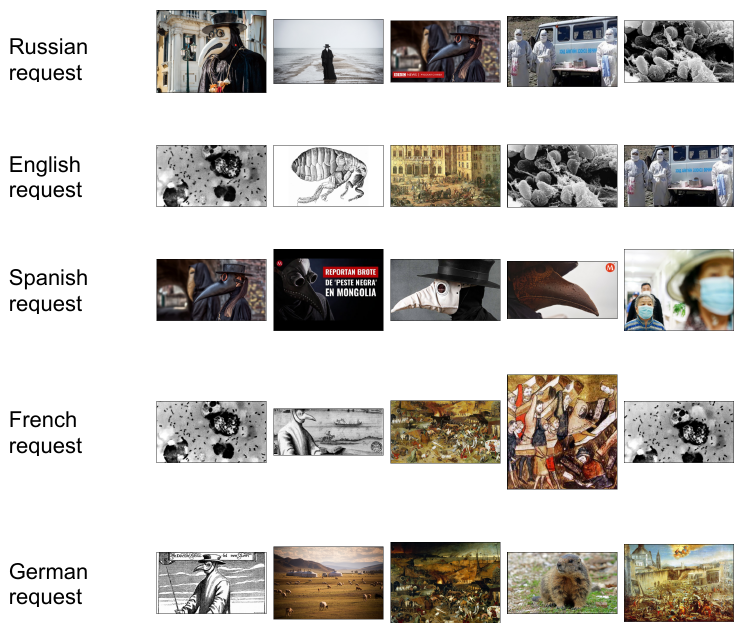
Figure A4. Top 5 images for legit news, “Bubonic plague outbreak in